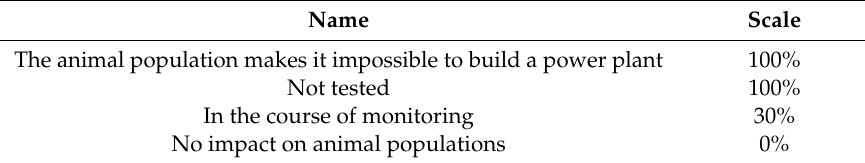
Table 4. Percentage scale of assessment of detailed criterion X 4,3 —impact on animal